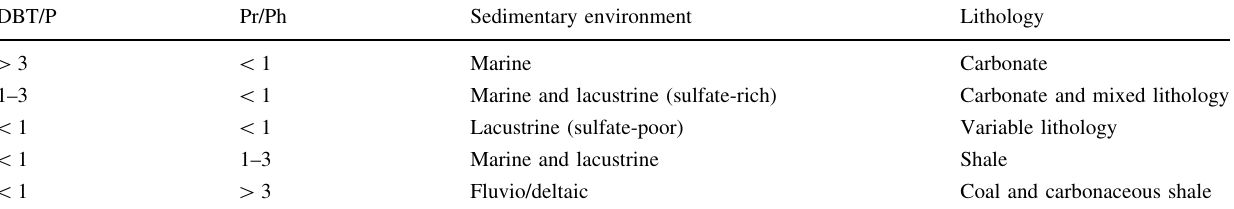
Table 5 Correlation between DBT/P and Pr/Ph from different environments (Hughes et al. 1995)